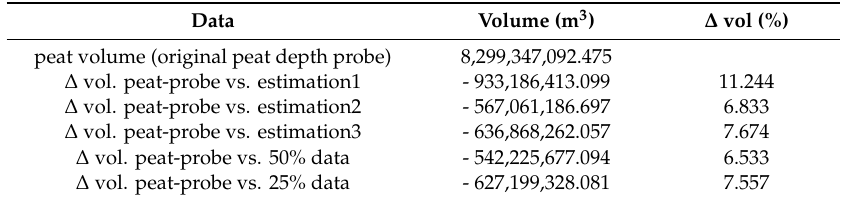
Table 8. Volume comparison between the models resulted from the ordinary least square (OLS) method and the filed